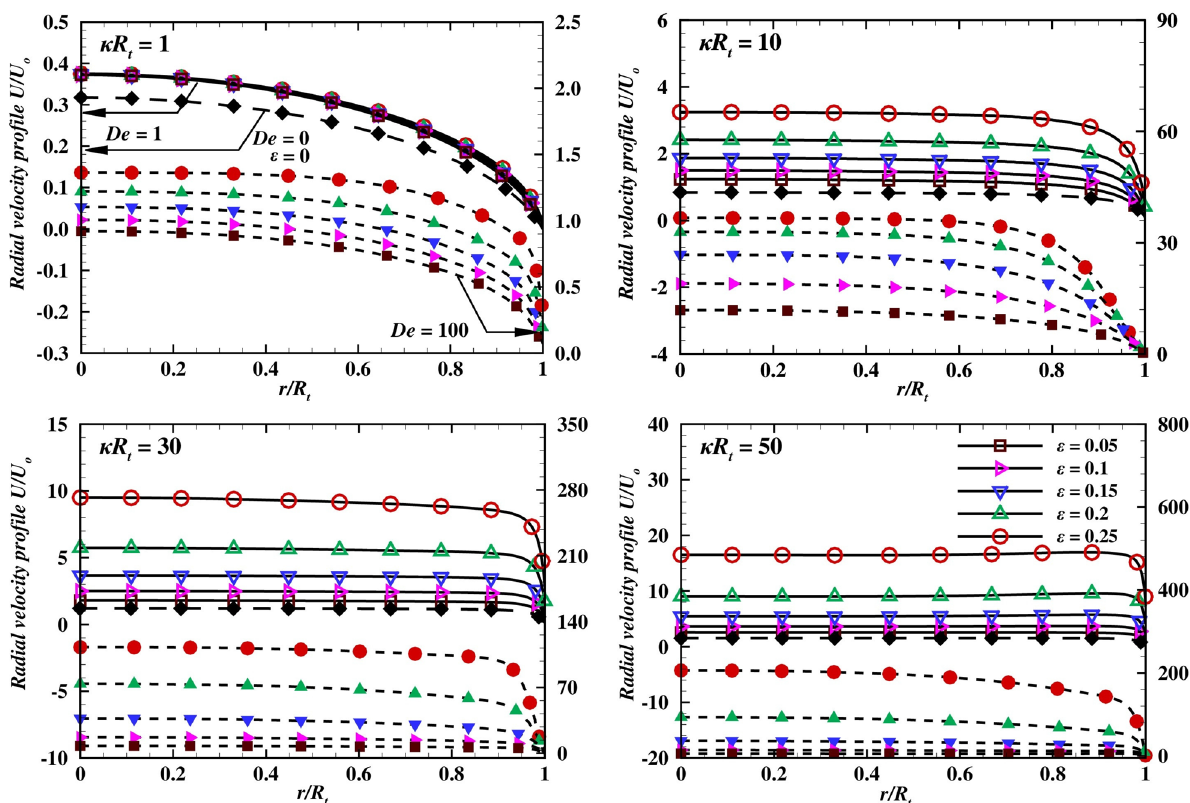
Figure 6. Radial velocity variation with ε at De = 1 (empty symbols) and De = 100 (filled symbols), V = 40 , σ = − 50 , and Newtonian fluid for various values of κ R t .